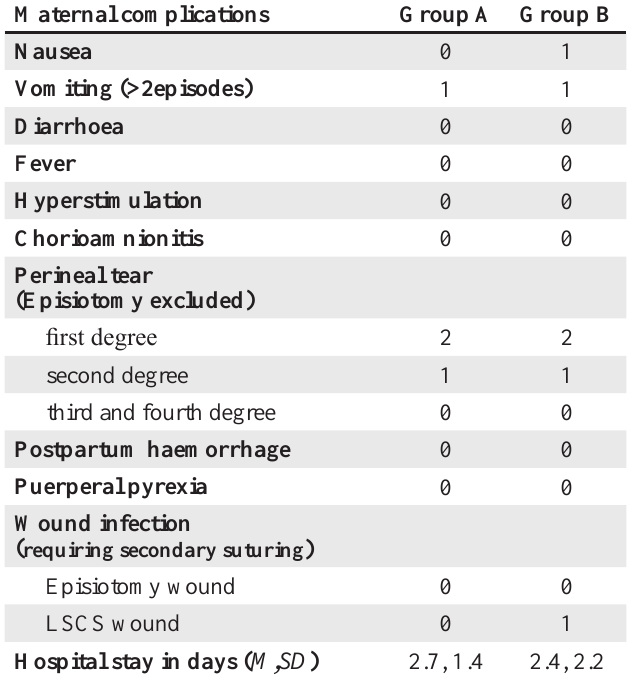
and neonatal infection. The number of vaginal examinations was higher in group B as multiple doses of prostaglandins were used in this group. The maternal complications were negligible Table 4: Distribution of cases according to maternal morbidities